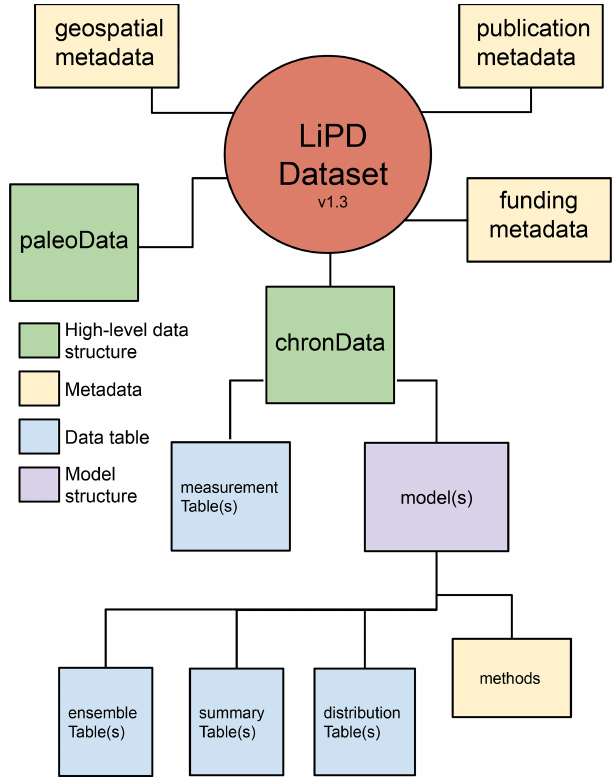
Figure 1. Schematic representation of a Linked PaleoData (LiPD) dataset, with a focus on chronological data. A LiPD dataset can con- tain one or more instances of all of the data objects and structures. The PaleoData structure mirrors that of the chronData but is not shown for